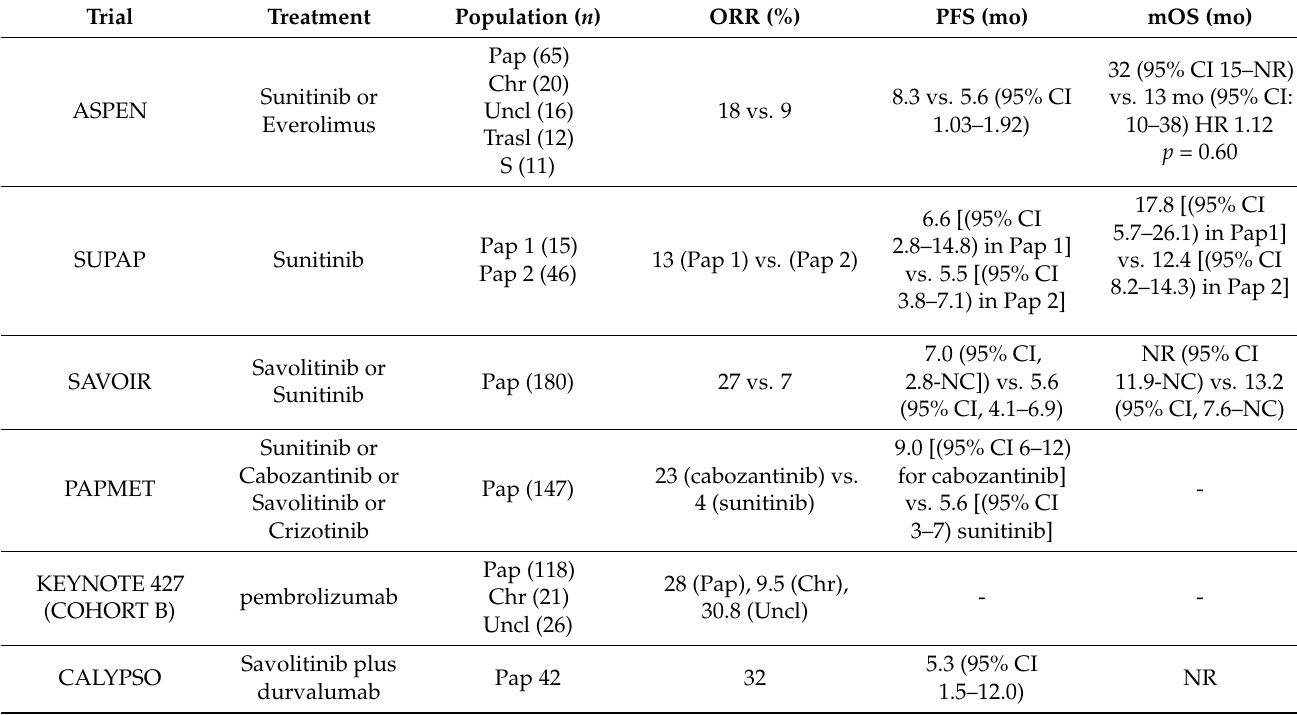
Table 2. Completed prospective trials evaluating treatment regimens for papillary renal cell carcinoma patients. ORR: objective response rate; PFS: progression free survival; mo: months; OS: overall survival; Pap: papillary; Chr: